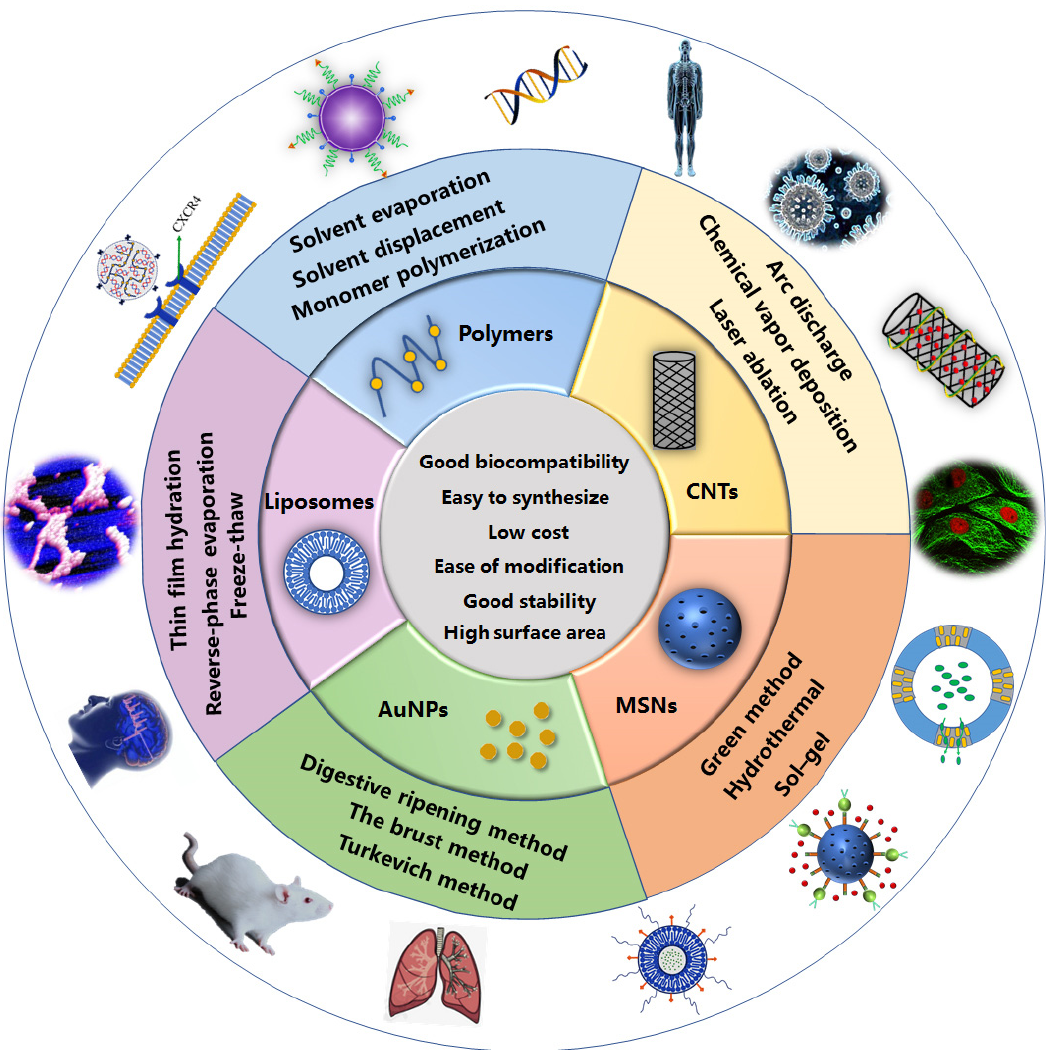
Figure 1. The characteristics, preparation methods, and biomedical applications of several non-viral vectors. Table 1. The characteristics and preparation methods of several non-viral vectors.